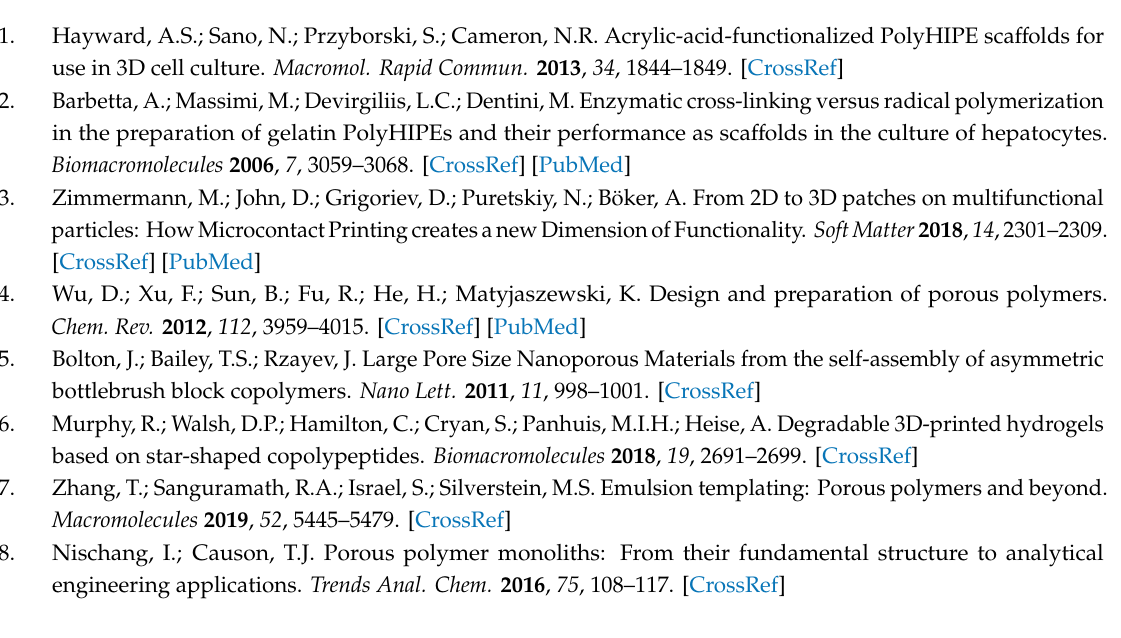
Table S4: The OD600nm values of E. coli proliferation in all